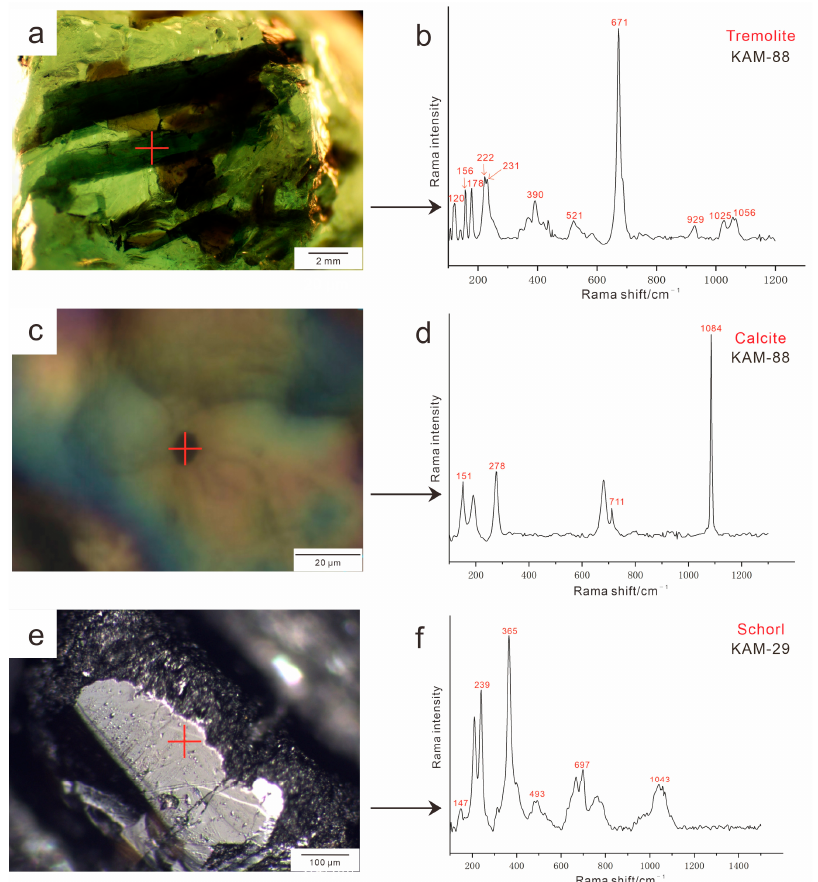
Figure 9. ( a ) Tremolite inclusion in a Kamakanga emerald (KAM-88) and ( b ) its Raman spectrum. ( c ) Calcite inclusion in a Kamakanga emerald (KAM-88) and ( d ) its Raman spectrum. ( e ) Schorl inclusion in a Kamakanga emerald (KAM-29) and ( f ) its Raman spectrum.